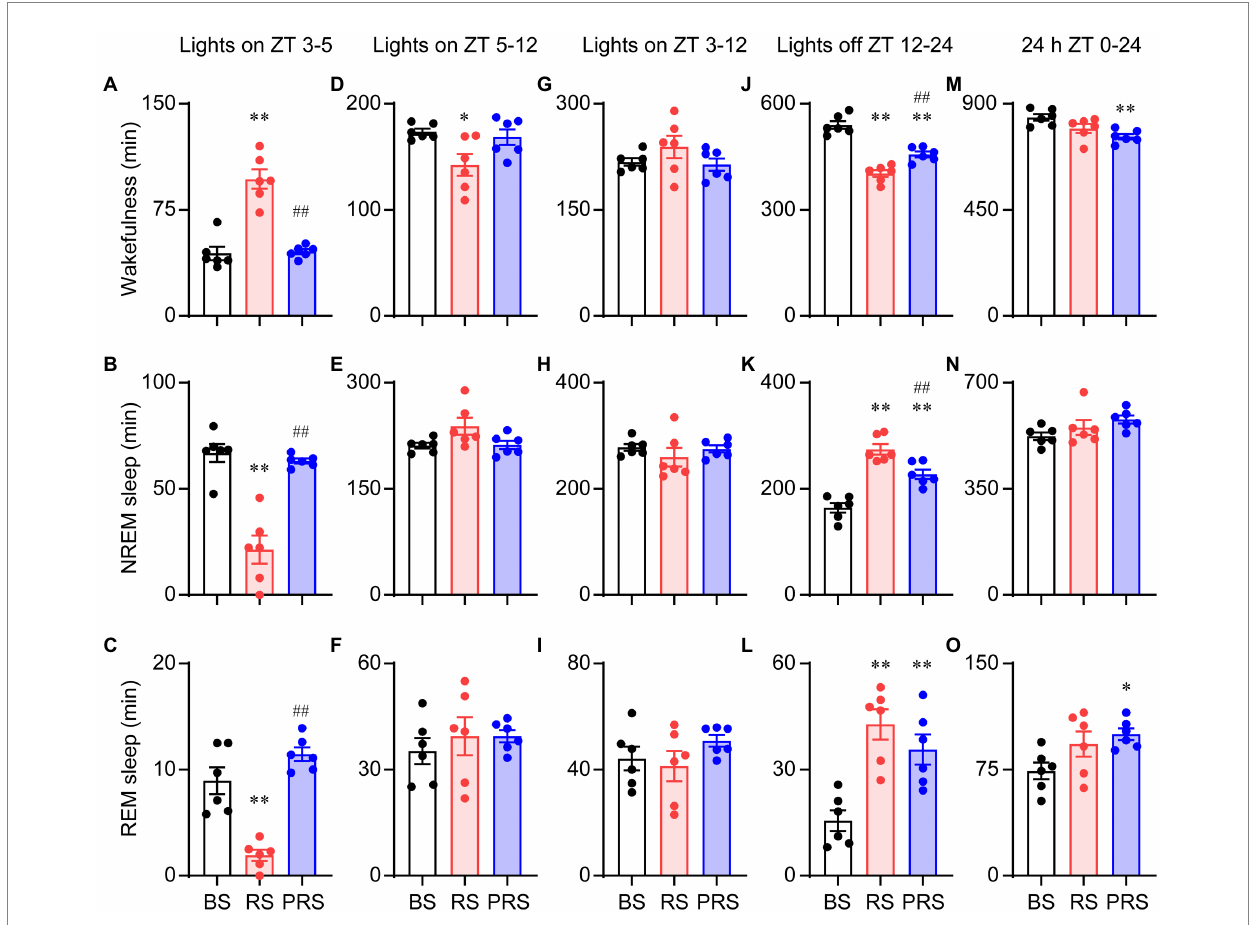
FIGURE 3 Cumulative time in the sleep–wake stages of the baseline, RS, and PRS conditions. Cumulative time of wakefulness (A) , NREM sleep (B) , and REM sleep (C) during ZT 3–5 (lights on). Cumulative time of wakefulness (D) , NREM sleep (E) , and REM sleep (F) during ZT 5–12 (lights on). Cumulative time of wakefulness (G) , NREM sleep (H) , and REM sleep (I) during ZT 3–12 (lights on). Cumulative time of wakefulness (J) , NREM sleep (K) , and REM sleep (L) during ZT 12–24 (lights off). Cumulative time of wakefulness (M) , NREM sleep (N) , and REM sleep (O) during ZT 0–24 (24 h). * p < 0.05, ** p < 0.01 versus baseline, ## p < 0.01 versus RS, n = 6. BS, baseline; RS, restraint stress; PRS, post-restraint stress; ZT, Zeitgeber